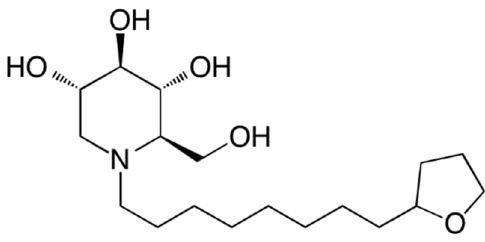
Figure 1. Structure of the iminosugar